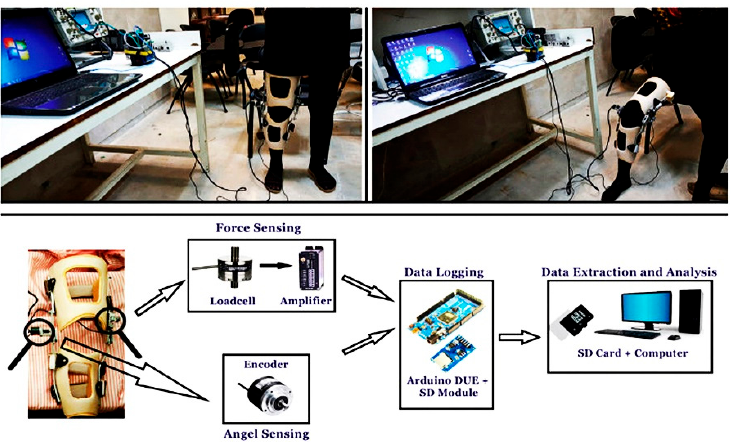
Figure 9. Knee orthosis with articular design [55].